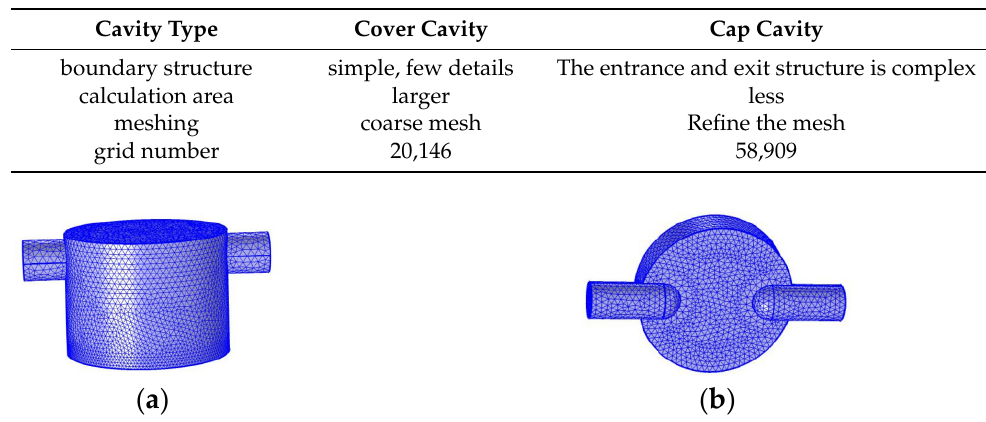
Table 4. Cavity type comparison. Cavity Type Cover Cavity Cap Cavity boundary structure